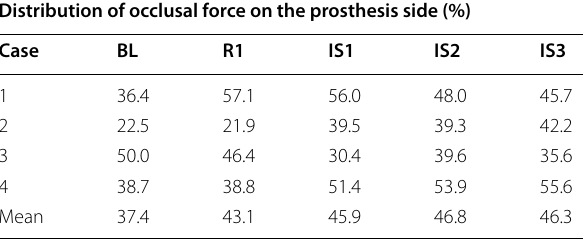
BL baseline, R1 3 months after insertion of removable partial denture (RPD), IS1 3 months after insertion of implant-supported RPD, IS2 6 months after insertion of implant-supported RPD, IS3 12 months after insertion of implant-supported RPD Table 5 Variation in distribution of occlusal force on the prosthesis